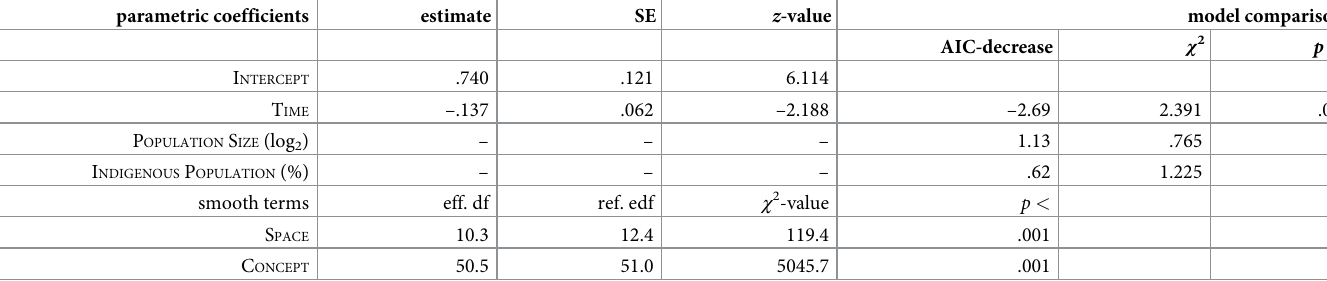
Table 3. Generalized additive mixed-effects model of maximal fit on the distribution indices of the selected variants ( n = 6,304). parametric